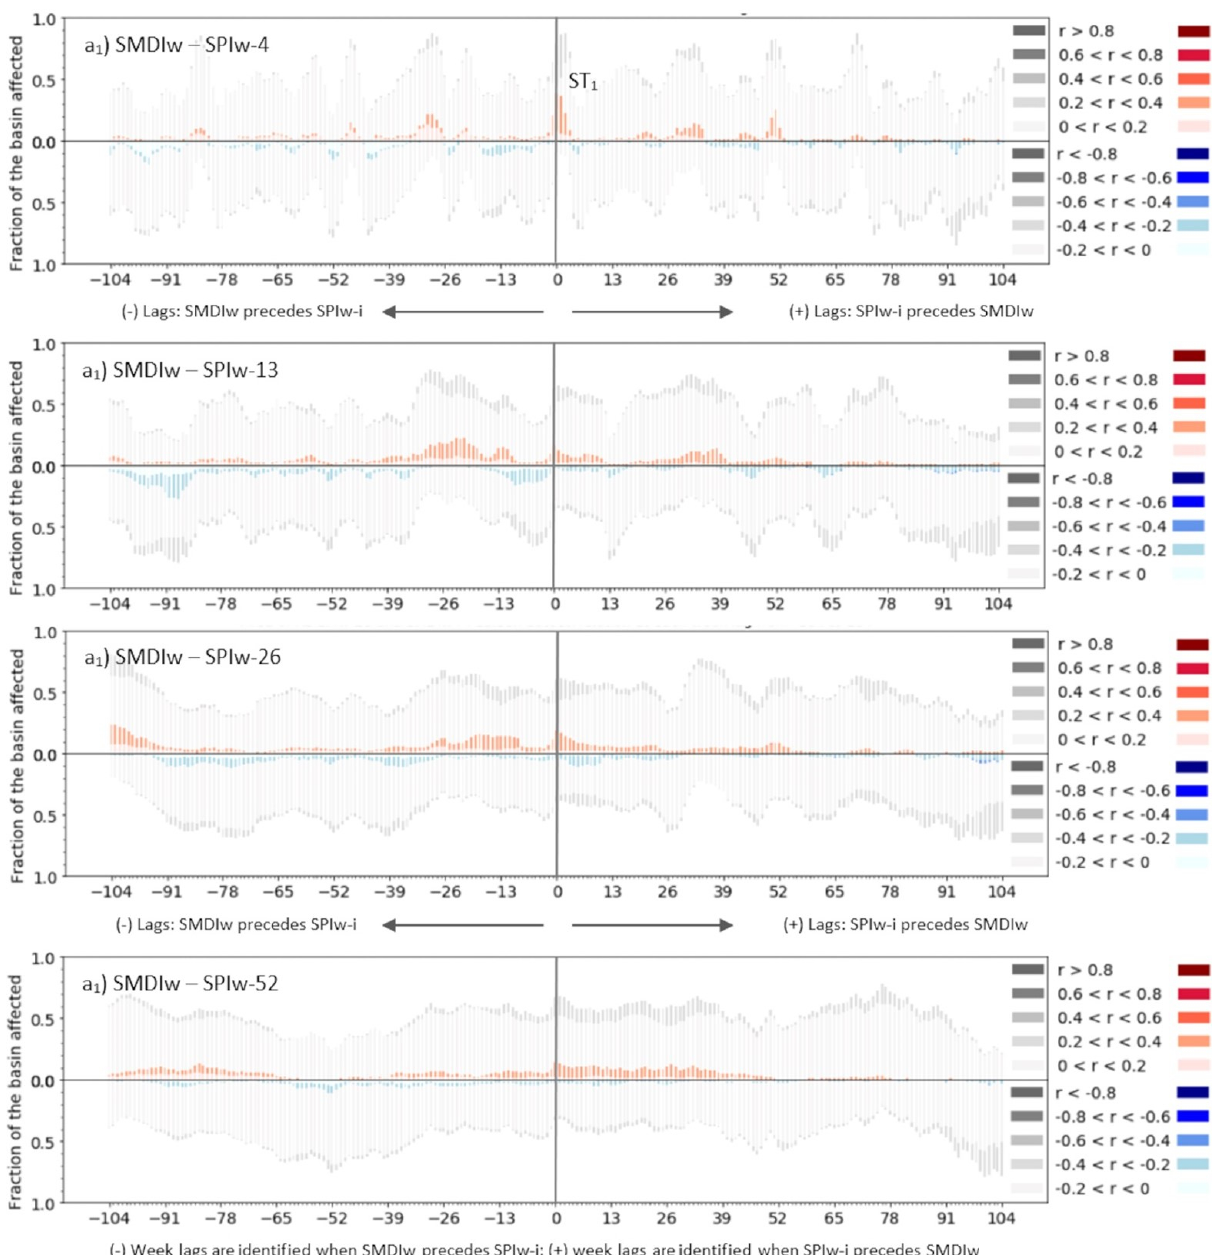
Figure 6. Lag plots of SPI-1, SPI-3, SPI-6 and SPI-12 (expressed as SPIw-4, SPIw-13, SPIw-26 and SPIw-52, respectively) with the land- surface model (LSM) SMDIw index at the weekly scale for the period 2010–2017. Lags are calculated for the − 104 leading and + 104 lagged time steps of SMDIw in reference to SPIw- i . The height of the bars of the plot indicates the area of the basin affected by non-significant (greyscale) or significant (colored scale) correlations. The saturation of the colored scale indicates the magnitude of the significant positive (red) or negative (blue) Pearson correlation coefficient of SPIw- i and